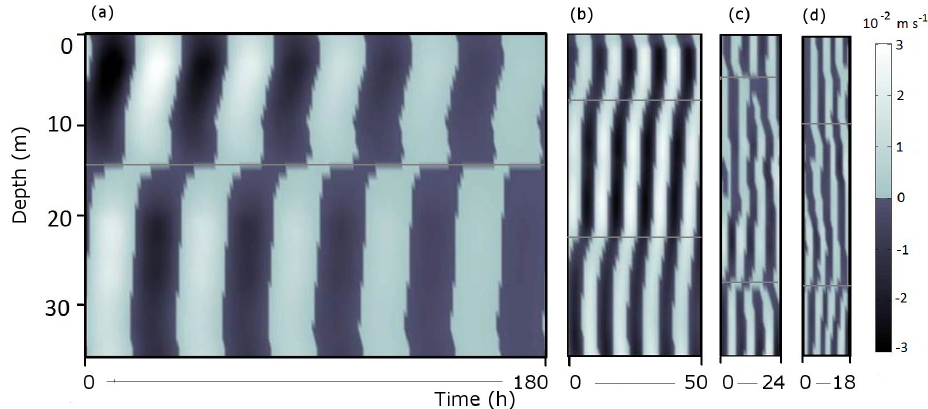
Figure 7. Filtered horizontal velocity along the main axis of the lake for internal seiches of (a) 36h, (b) 11h, (c) 7h and (d) 5h in 2006. The grey horizontal lines indicate the interfaces between